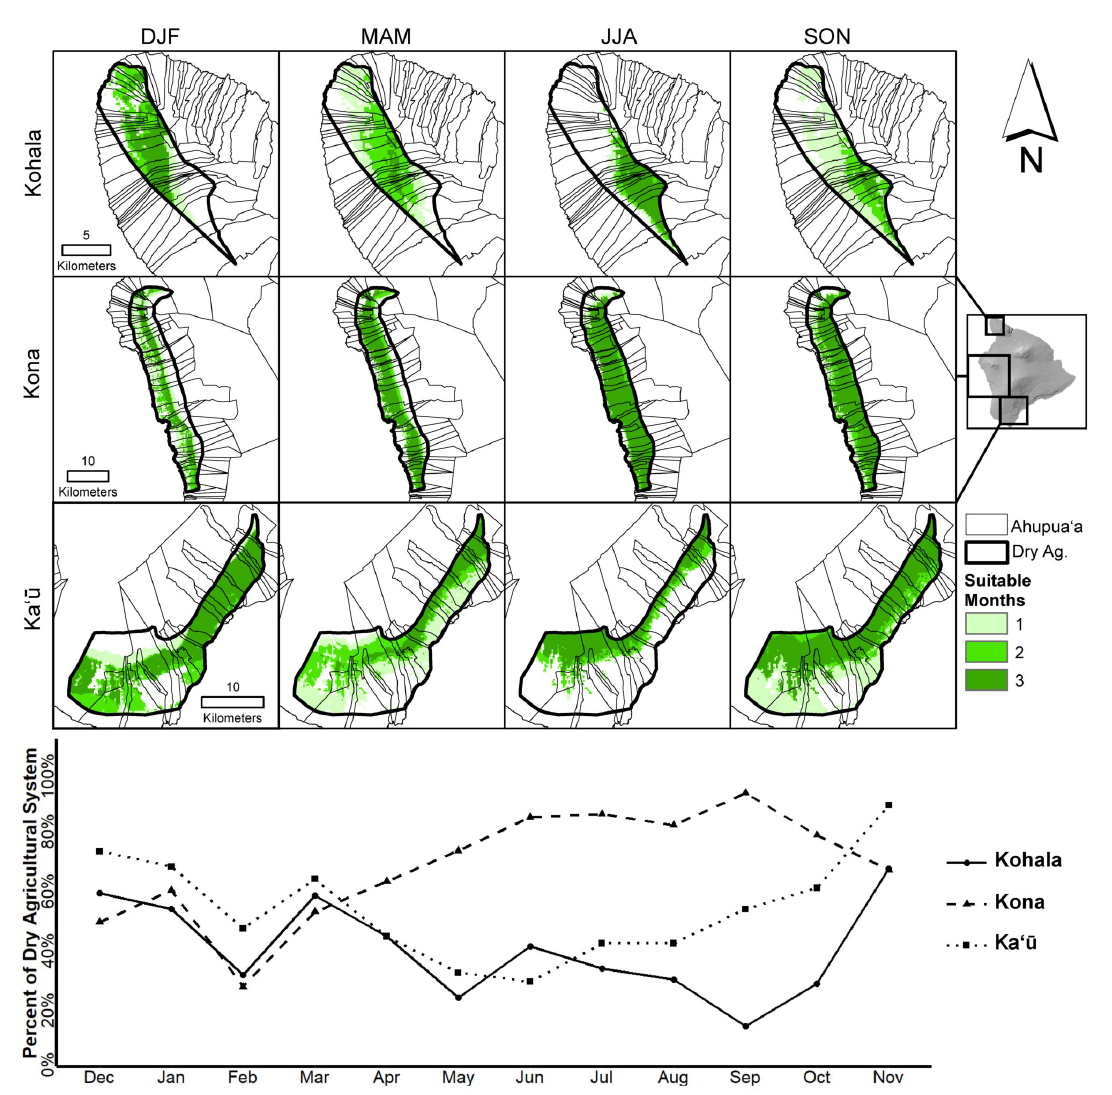
Fig. 6 . Maps of seasonally shifting optimal conditions for ʻ uala (sweet potato, Ipomea batatas ) establishment in the Kohala, Kona, and Ka ʻū field systems using monthly criteria Tmean > 18 °C and PET/P < 2.5. Monthly data are binned for visual simplicity while the graph below indicates percentage of each field system that is cultivable in each